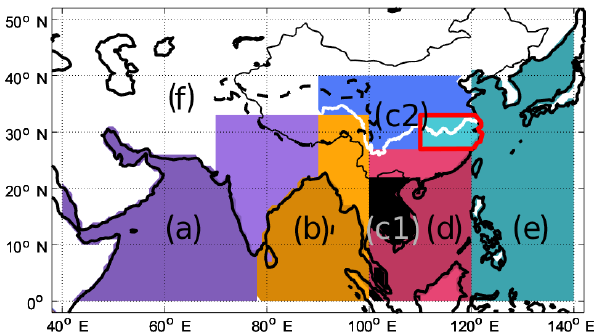
Figure 4. Definition of source regions. The different regions are named (a) Arabian Sea and India, (b) Bay of Bengal and Myanmar, (c1) Indochina Peninsula, (c2) Central China, (d) South China Sea and South China, (e) Western Pacific and the target region of the lower Yangtze River valley, and (f) remaining ocean and land re- gions. The target region (red) and 4000m elevation of the Tibetan Plateau (dotted contour) are shown. Table 1. Moisture source contribution fraction to the Yangtze River valley (YRV) in percent. Averages are weighted by monthly contri-